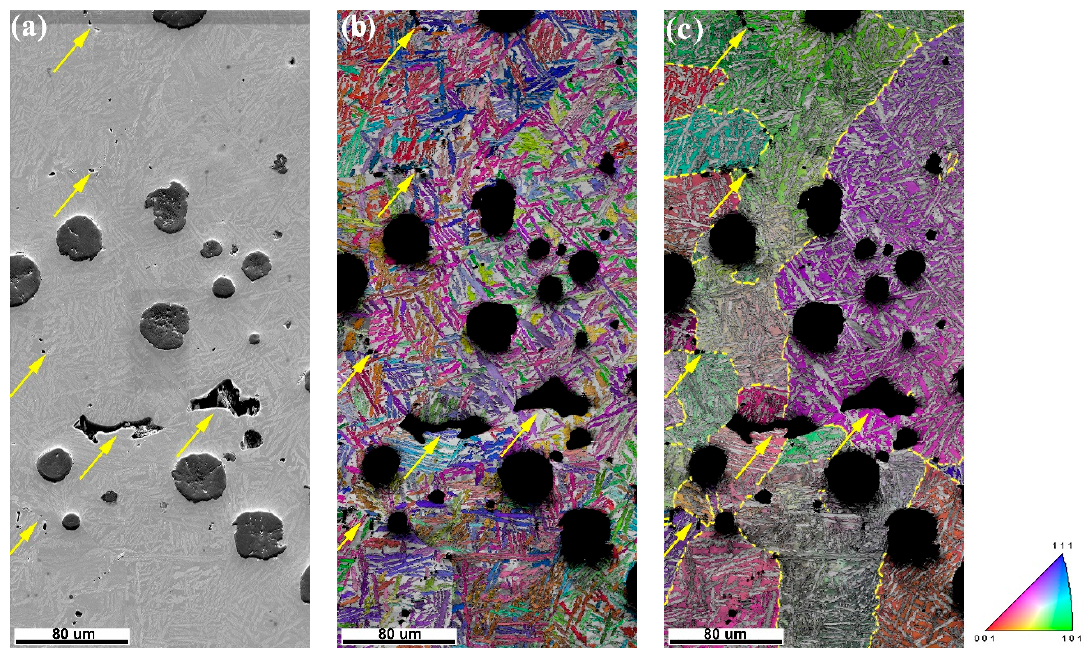
Figure 2. ( a ) Middle cross section of the “bathtub” component; ( b ) SEM image of the region of interest (ROI); IPF map of ( c ) ferrite and ( d ) austenite phases, over-imposed to the image quality (IQ) map. Austenite high angle grain boundaries (misorientation > 15°) are highlighted by yellow lines in ( d ). Arrows show the micro-shrinkage porosities and circle is highlighting the accumulation of microporosities at the junction of austenite grain boundaries.